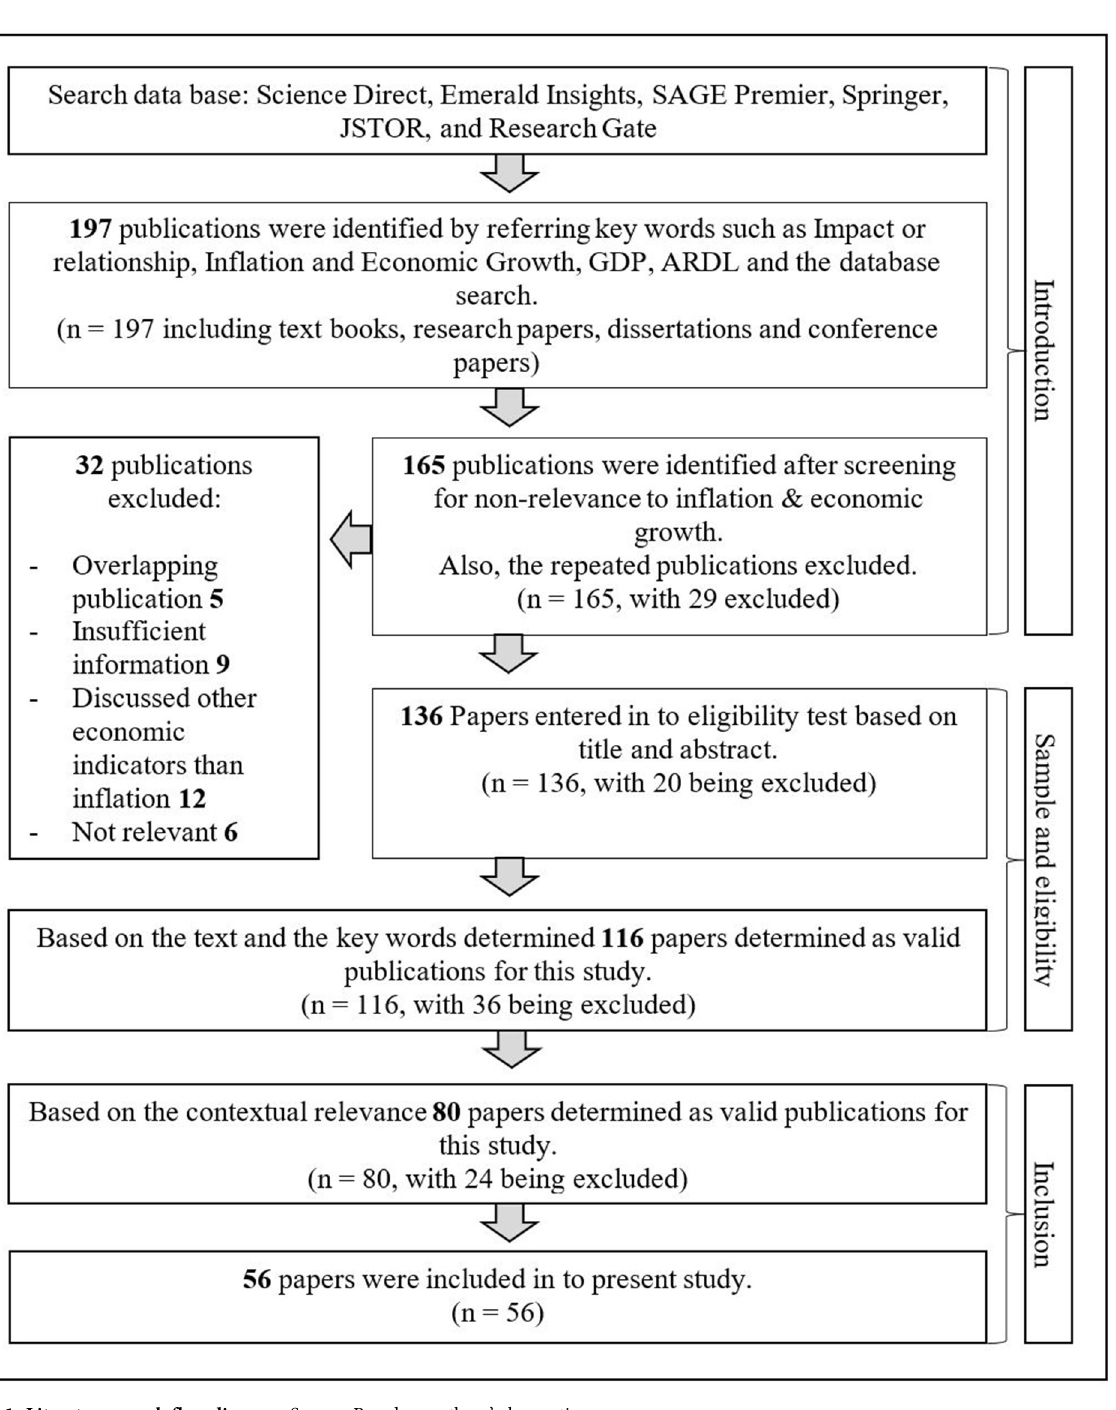
Fig 1. Literature search flow diagram. Source: Based on authors’